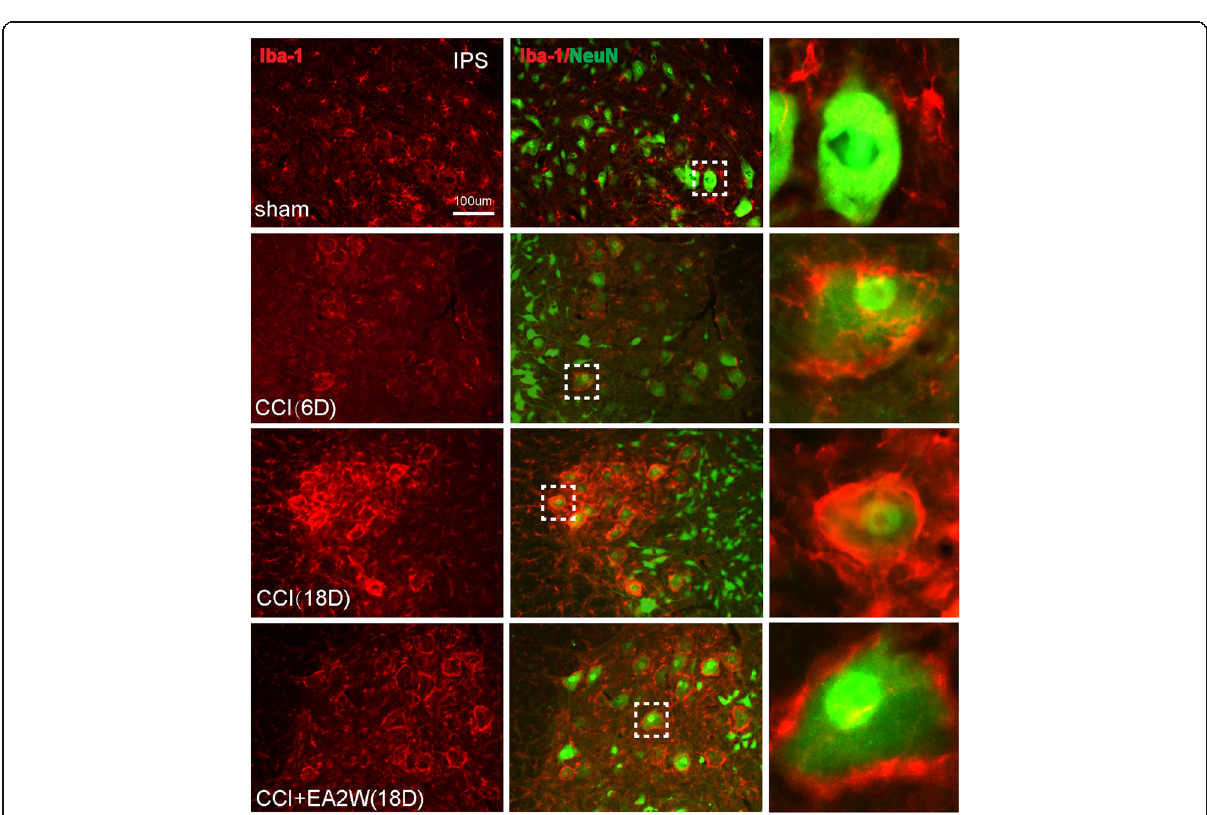
Fig. 5 Representative section samples of dual immunofluorescent staining of Iba-1 (red) and neuronal nuclei (NeuN, green) for microgliacytes and neurons in the Ipsi ventral horns of lumbar spinal cord in the sham, CCI 6D and 18D, and CCI + EA2W groups. The images from the left to the right longitudinal rows are Iba-1-labeled microgliacytes, Iba-1 and NeuN labeled cells and magnified cells chosen from the dashed square box of each image on their individual left side. The NeuN-positive neurons were closely surrounded by many microgliacytes after CCI, suggesting a remodeling of the lumbar locomotor circuitry. NeuN, a neuronal specific nuclear protein and a biomarker for neurons